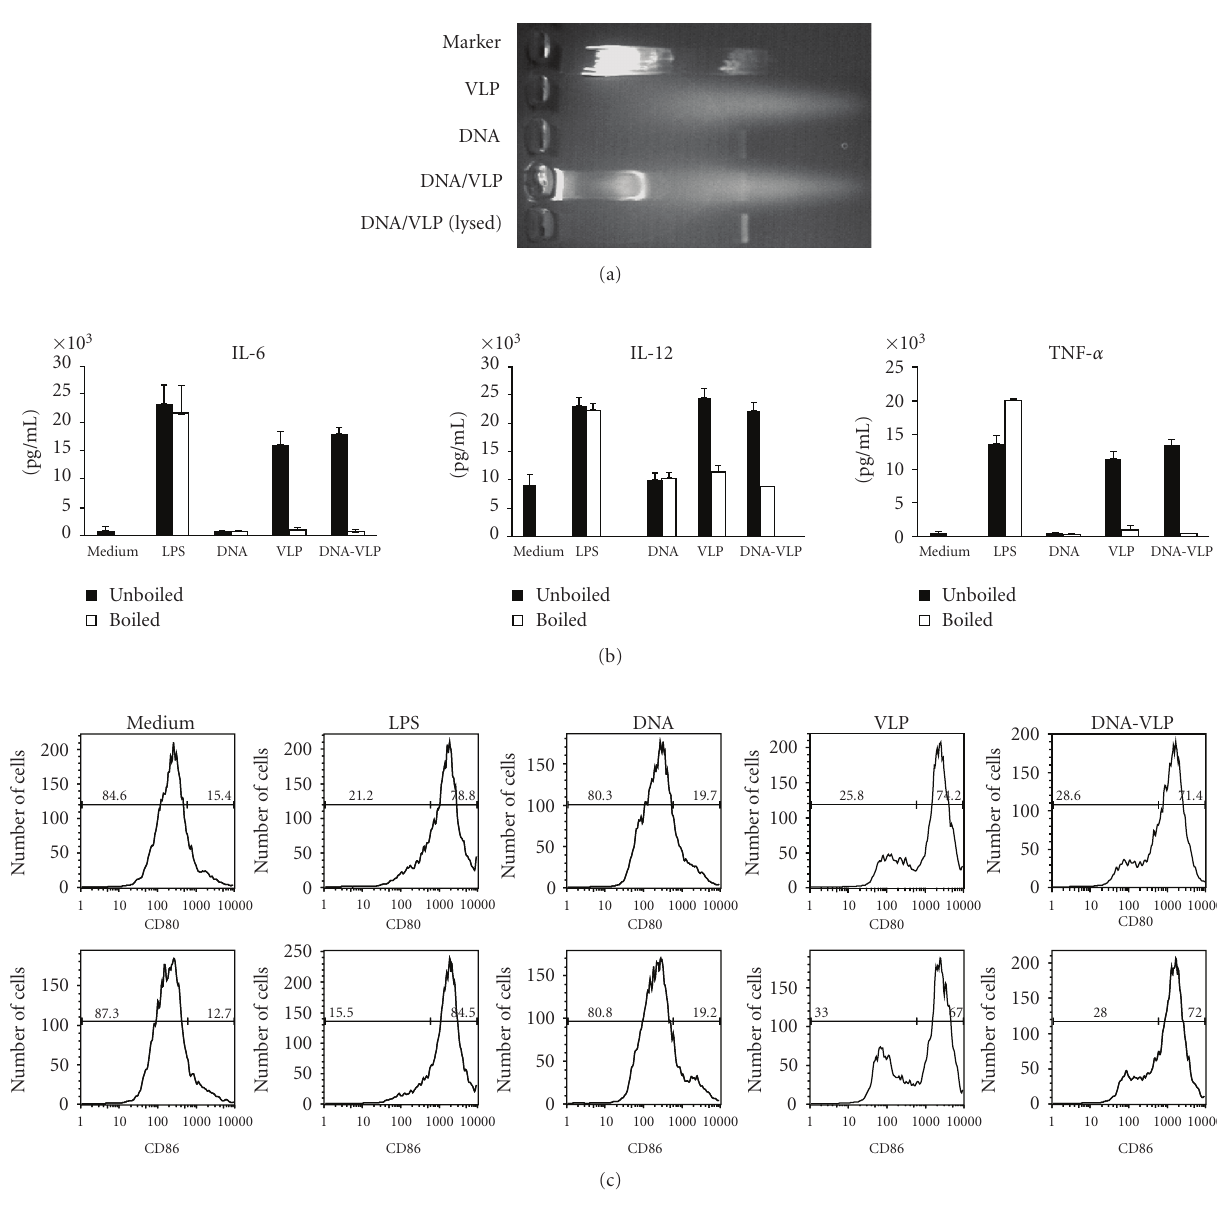
Figure 5: (a) DNA molecules bind to VLPs in the DNA/VLP mixture. HIV 89.6 Env - DNA, SHIV 89.6 VLPs, or their mixtures were loaded onto a two-layer sucrose cushion, with 500 μ l 30% sucrose at bottom and 2 mL 20% sucrose above, followed by ultracentrifugation. After centrifugation, 10 μ l from the 30% cusion of each sample was loaded onto a 1% agarose gel, and after electrophoresis, the gel was stained with Ethidium Bromide followed by destaining and then visualization of DNA by UV light. Marker: DNA molecular weight marker (lambda DNA Hind III digest); VLP: 50 μ g SHIV 89.6 VLPs; DNA: 50 μ g HIV Env-DNA; DNA/VLP: 50 μ g HIV Env-DNA mixed with 50 μ g SHIV: 89.6 VLPs; DNA/VLP (lysed): 50 μ g HIV Env-DNA mixed with 50 μ g SHIV 89.6 VLPs that were lysed with 1% Triton X-100. (b) SHIV 89.6